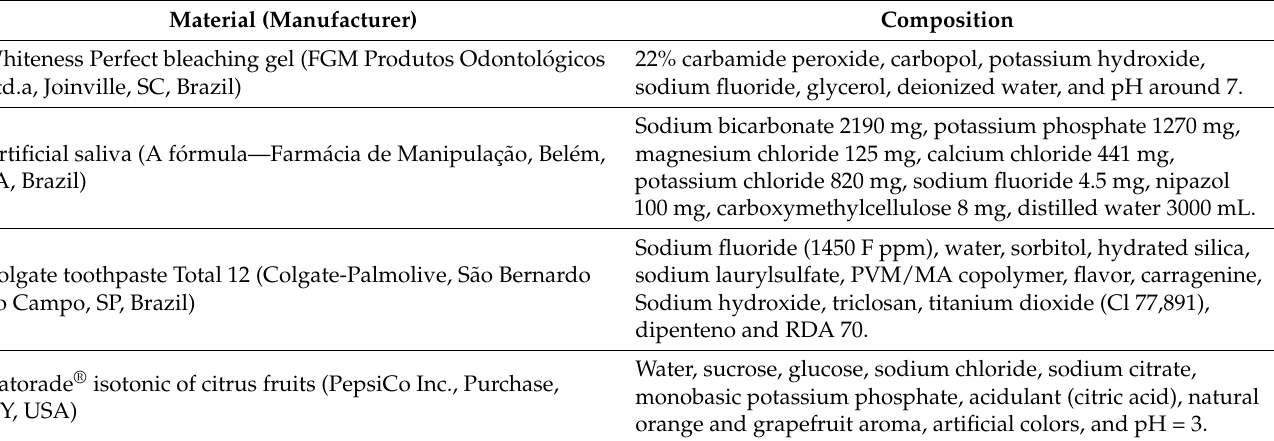
Table 1. The description of materials used including their trade names and manufacturers .